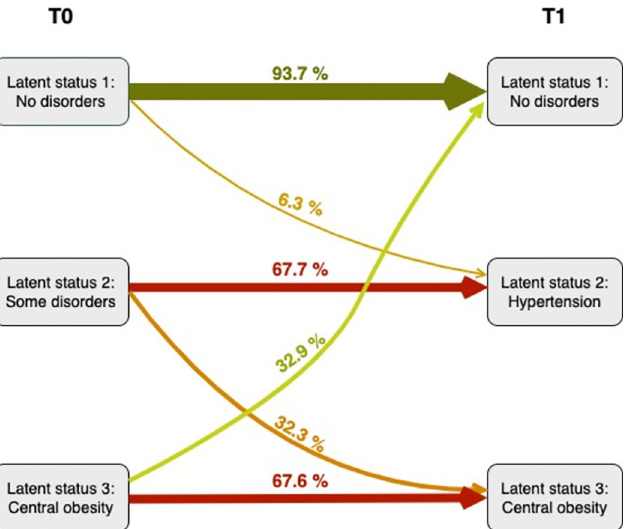
Fig 3. Probability of transitioning to each latent status at T1 (8 years), conditioned by the latent status at T0 (4 years). There were 154 subjects who had measurement of all variables performed at the two time points. Data are expressed as a